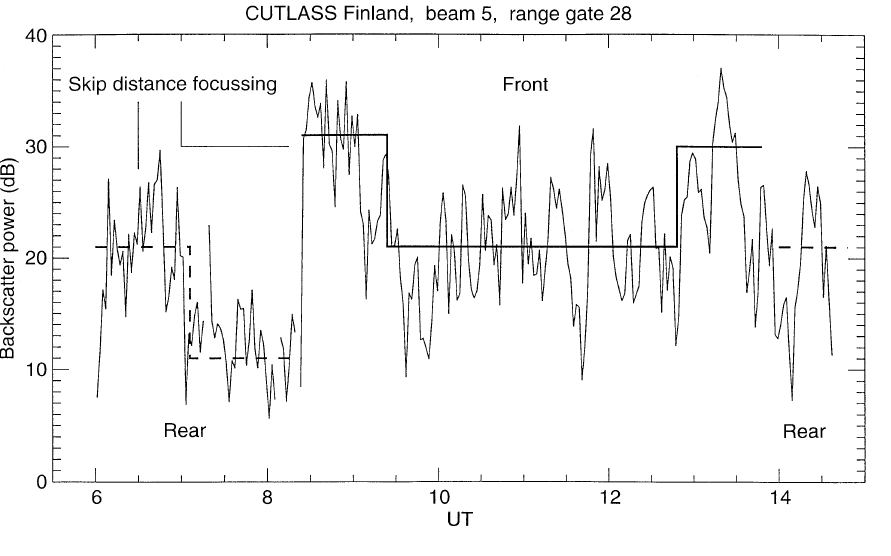
Fig. 7. Backscatter power variation for beam 5, range gate 28, of the Finland radar for 0530 UT to 1500 UT 25 November 1995. Overlaid is an approx- imate mean variation for backscatter identified as originating in the front ( solid line ) and rear ( dashed line ) fields-of- view